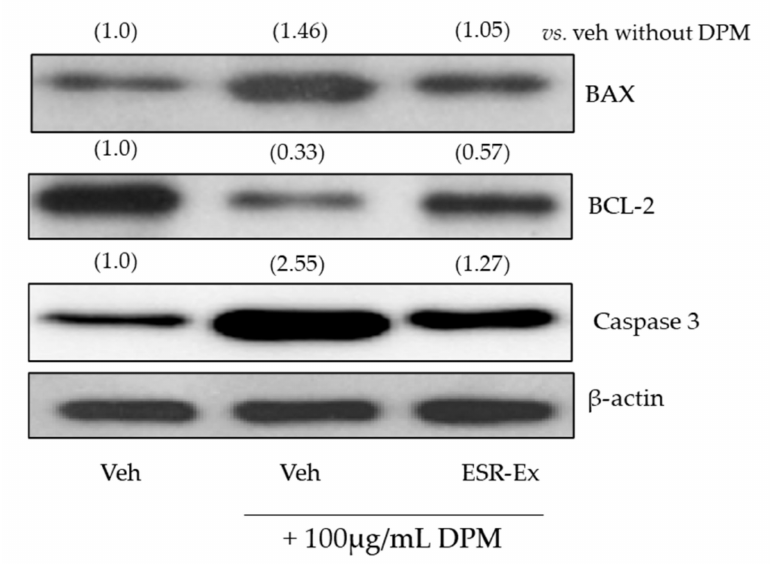
Figure 8. ESR-Ex suppresses increases in BAX, Caspase 3, and conversely decreases in BCL-2 proteins levels in KC exposed to DPM. KC were incubated with or without ESR-Ex (100 µ g/mL), Apo (100 µ M) or vehicle for 30 min, and then further cultured with 100 µ g/mL of DPM for 24 h. BAX, BLC-2, Caspase 3 and β -actin were analyzed by Western blot. Fold changes compared with the vehicle without DPM are shown in parentheses. See details in Materials and Methods